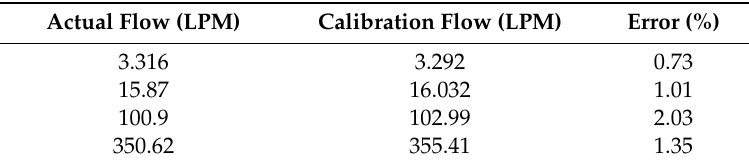
Table 4. Results from the flowmeter calibration.